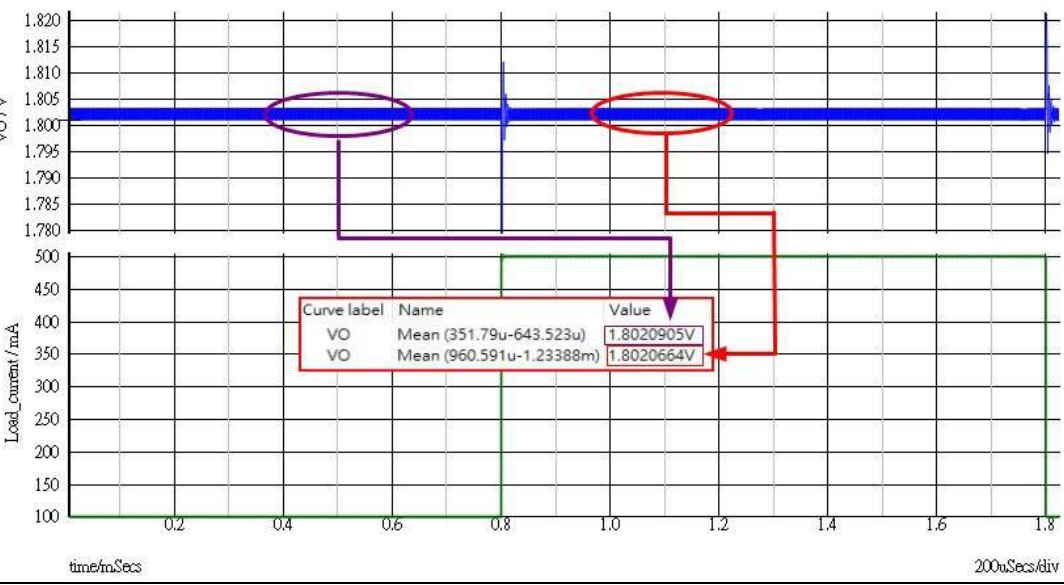
Figure 11. Load regulation.